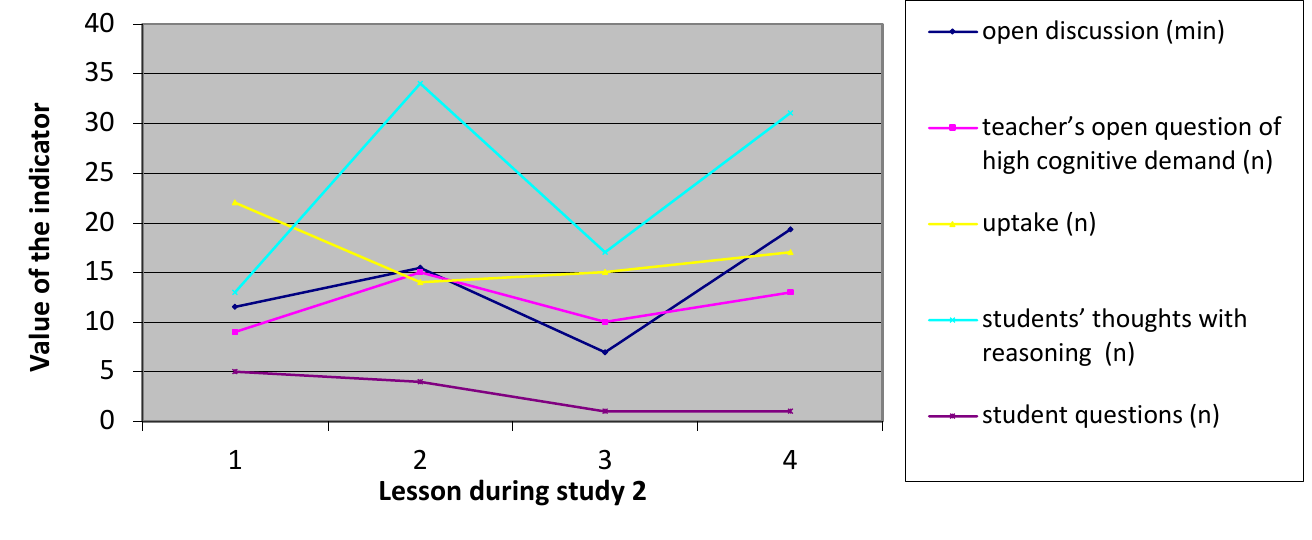
Figure 3: Development of dialogic indicators during Study 2 (February 2018 – May